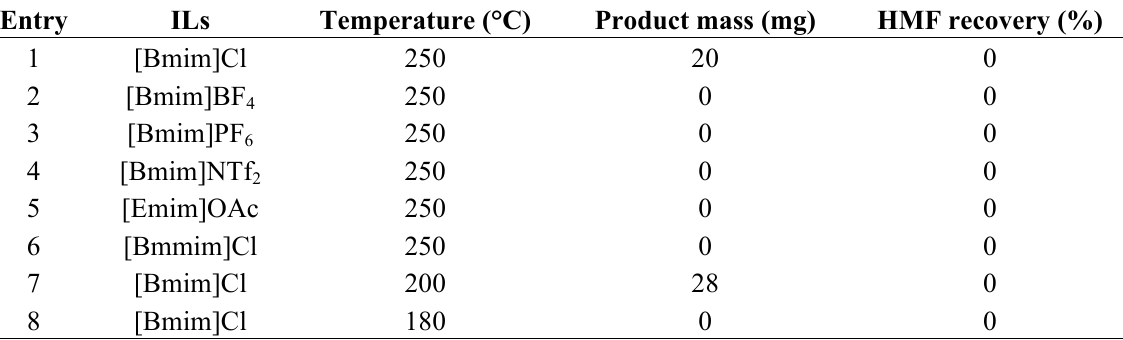
Table 1. The results of HMF reaction with different ILs a